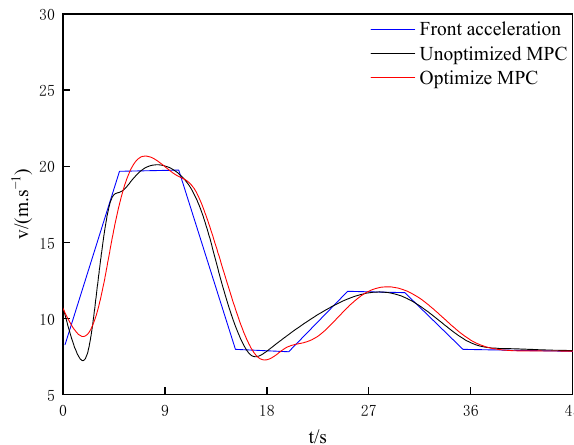
Figure 3. Simulation results of vehicle speed.